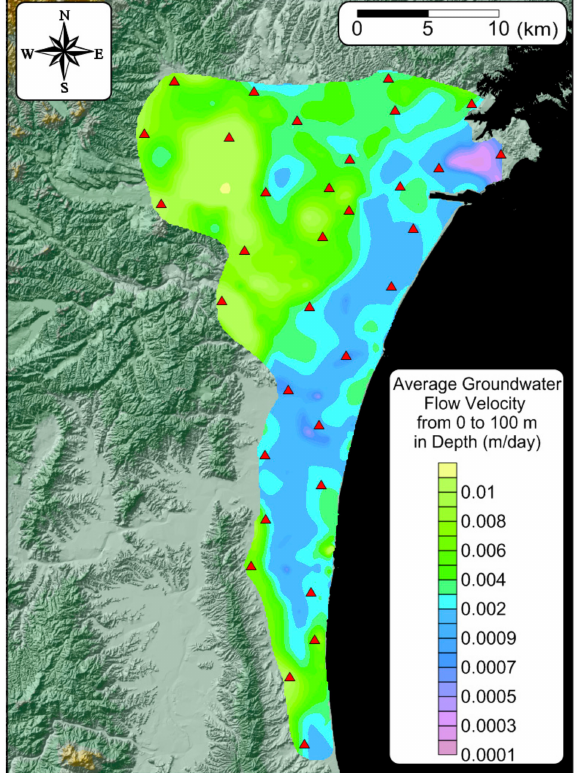
Figure 8. Distribution map of heat exchange rates for the Sendai Plain.